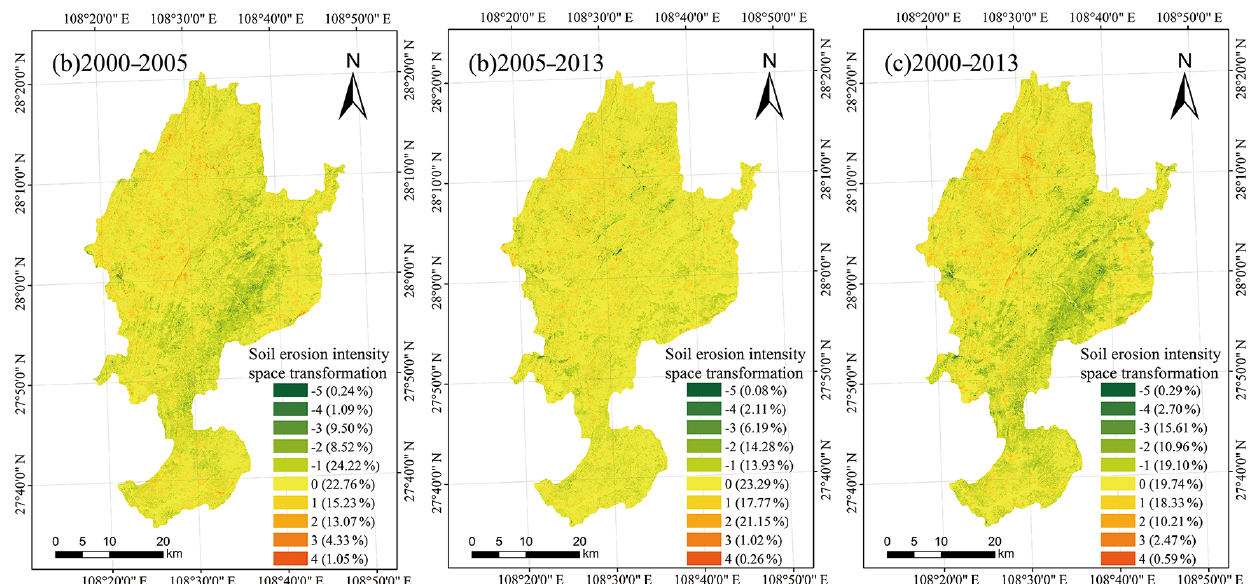
Figure 5. The intensity variation map of the soil erosion in Yinjiang. Note: 0 refers to unchanged soil erosion intensity; 1 refers to the soil erosion intensity increasing by one level; 2 refers to the soil erosion intensity increasing by two levels; 3 refers to the soil erosion intensity increasing by three levels; 4 refers to the soil erosion intensity increasing by four levels; 5 refers to the soil erosion intensity increasing by five levels; − 1 refers to the soil erosion intensity decreasing by one level; − 2 refers to the soil erosion intensity decreasing by two levels; − 3 refers to the soil erosion intensity decreasing by three levels; − 4 refers to the soil erosion intensity decreasing by four levels; and − 5 refers to the soil erosion intensity decreasing by five